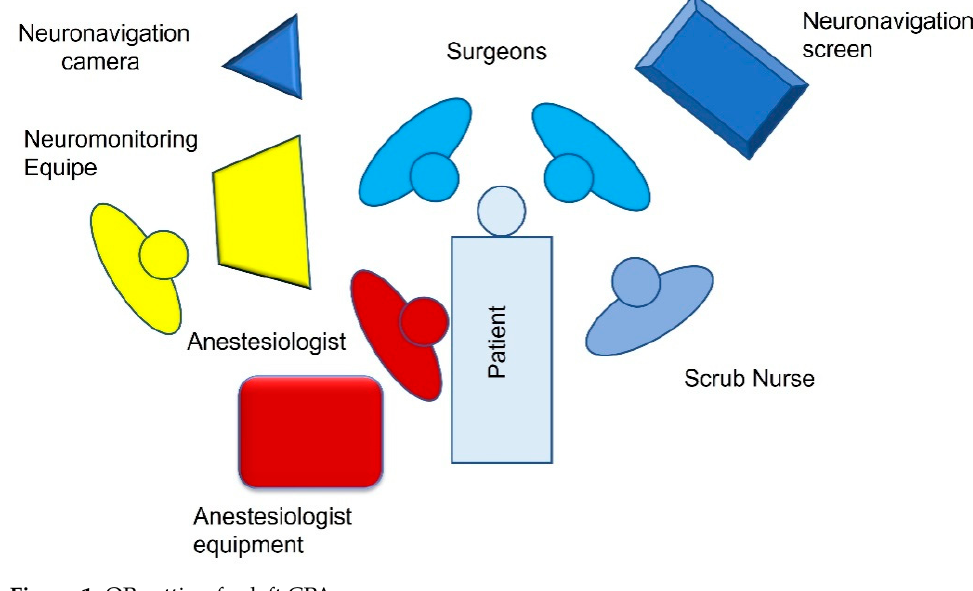
Figure 1. OR setting for left CPA surgery.